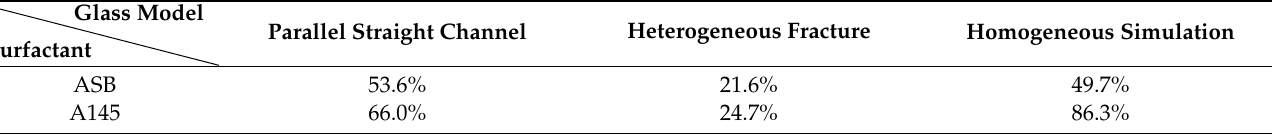
Figure 7. The final state of crude oil displacement of ASB ( A ) and A145 ( B ) solutions in homogeneous simulation model. Table 1. The oil displacement efficiency of ASB and A145 solutions in three visual glass models.